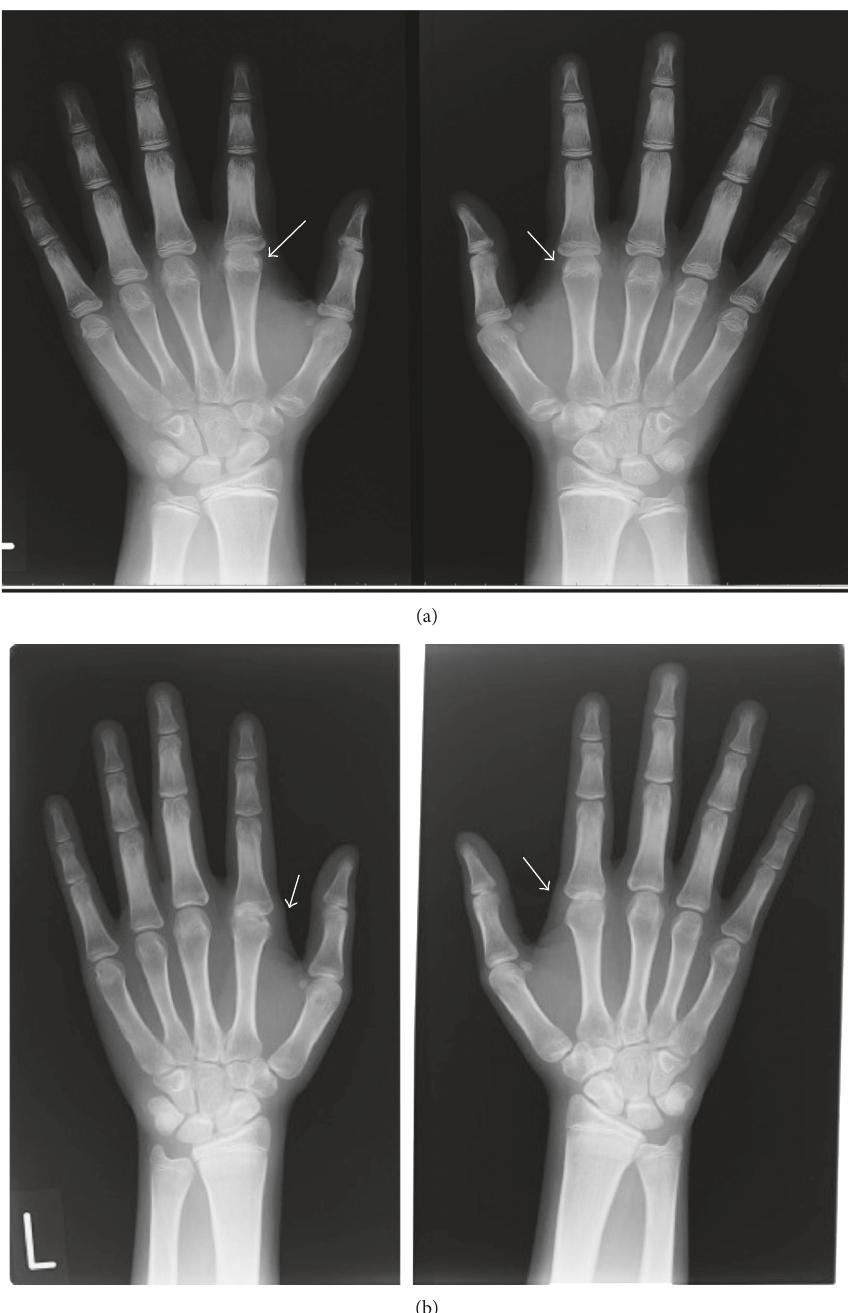
Figure 2: Radiography of both hands. (a) In September 2014, at the initiation of adalimumab when the patient was 12 years and 1 month of age. (b) In September 2016, after 2 years of adalimumab treatment when the patient was 14 years and 1 month of age. Narrowing of the metacarpophalangeal joints of both index fingers was observed when adalimumab was started (a), and more progressive joint space narrowing existed under treatment with adalimumab, whereas insignificant bone erosion was observed